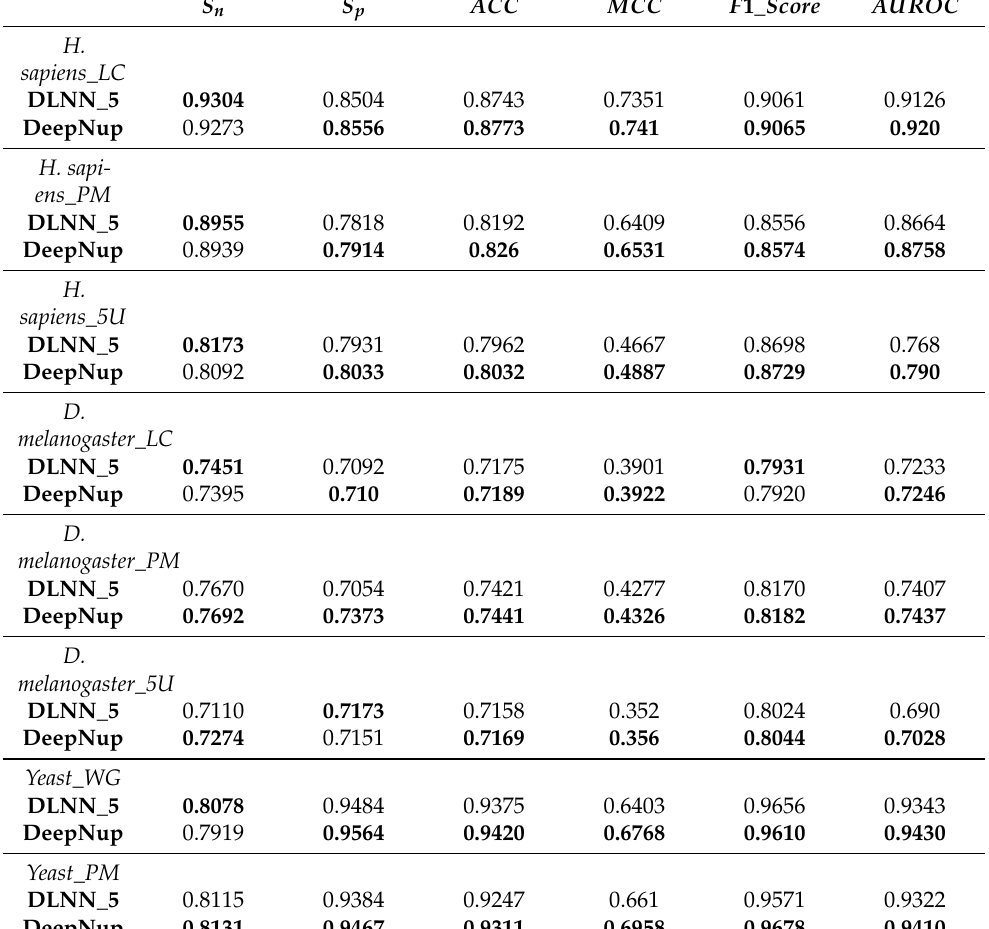
Table 6. Comparison of DeepNup with DLNN_5 via 10-fold cross validation on 8 datasets. S n